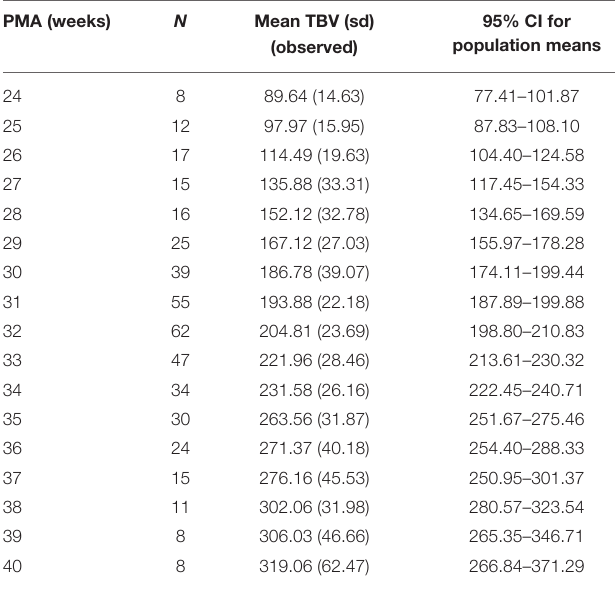
TABLE 2 | Observed means and 95% confidence interval for population means of US total brain volume (cm 3 ) by post-menstrual